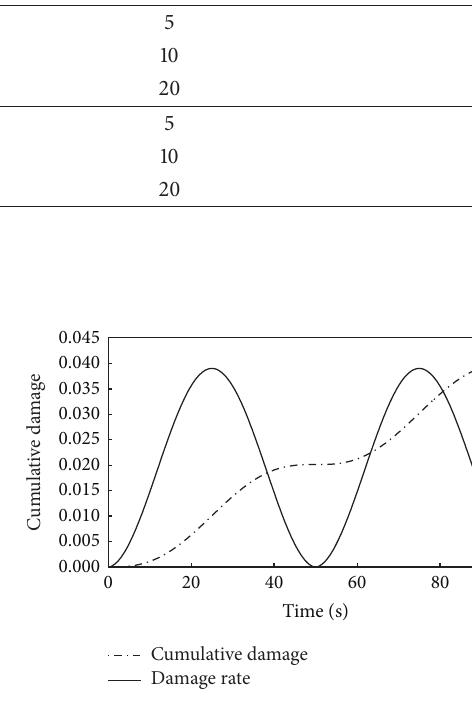
Figure 4: Damage rate and cumulative damage versus load time in a single loading cycle (20 ∘ C, rubber asphalt-PAV, stress amplitude 0.5 MPa)